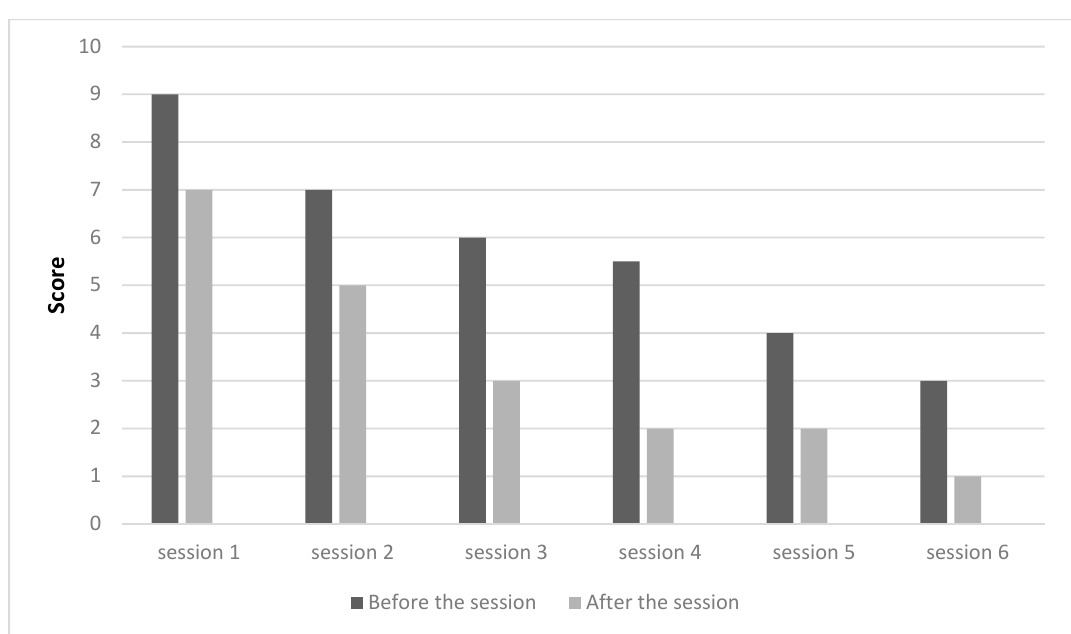
Figure 2. Assessment of pain per session, subject B.